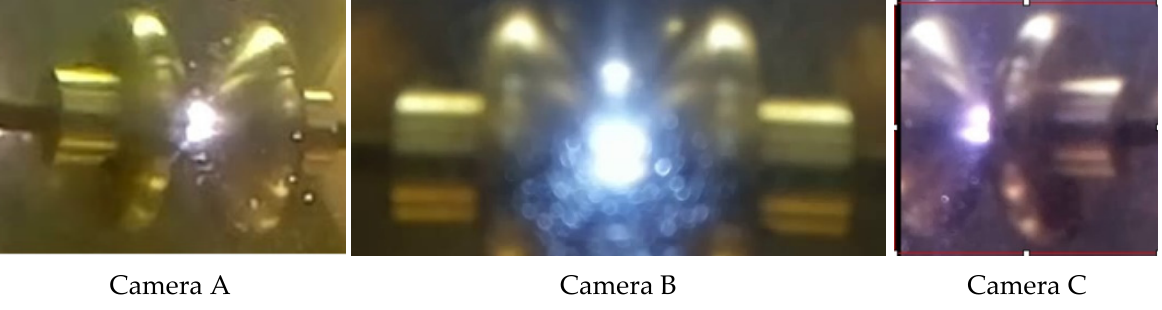
Figure 12. Capture of the images of the electric arc by cameras ( A – C ).